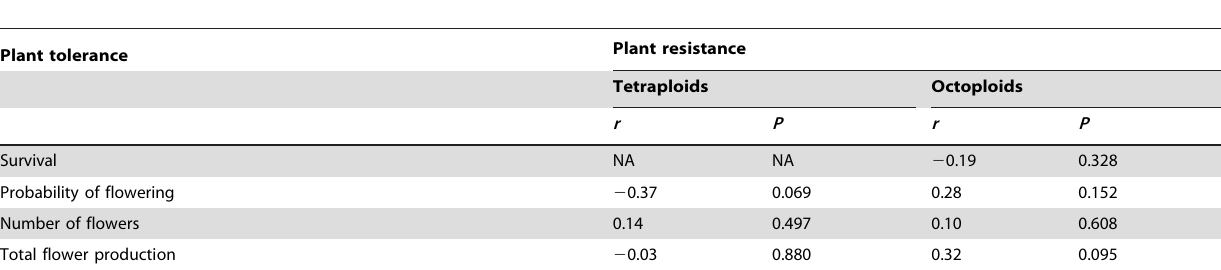
Table 4. Relationship between four estimates of tolerance and variation in resistance among populations of two ploidy types in the perennial herb Cardamine pratensis